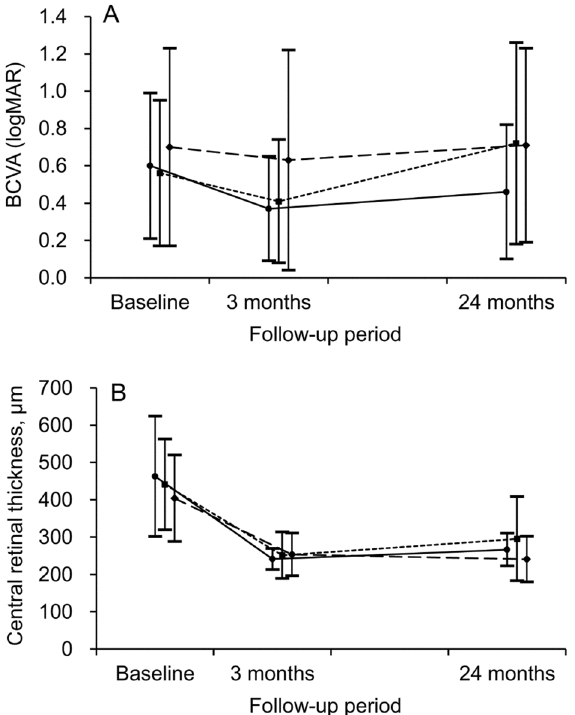
Figure 1. Time-dependent changes in best-corrected visual acuity (BCVA) ( A ) and central retinal thickness ( B ), according to the treatment groups: treat-and-extend group = closed circle, solid line (n = 32); as-needed group = closed square, dotted line (n = 74); no-reactivation group = closed diamond, dashed line (n = 26). Note that BCVA markedly deteriorates after 3 months in the as-needed group, whereas the degree of deterioration is relatively lower in the other two groups ( A ). logMAR logarithm of minimal angle of resolution.